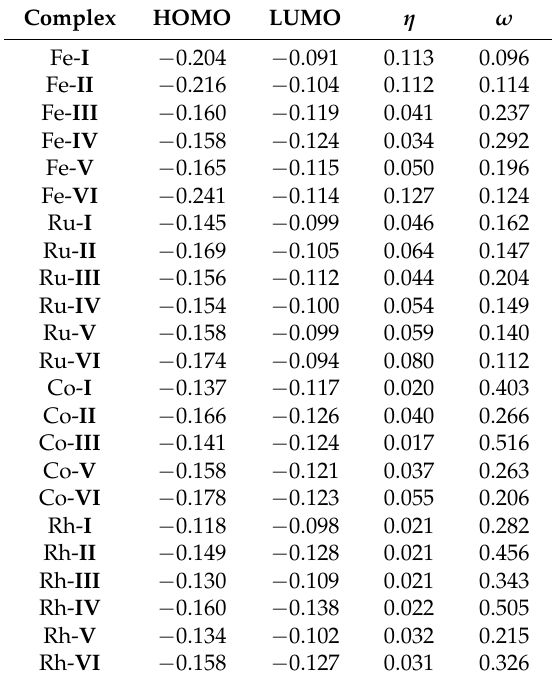
Table 4. Highest occupied molecular orbital (HOMO), lowest unoccupied molecular orbital (LUMO), chemical hardness ( η ), and electrophilicity ( ω ) for the computed stationary points for the olefin metathesis reaction pathway for M(SIMes)Cl 2 (=CHPh)PPh 3 (M = Ru, Co, and